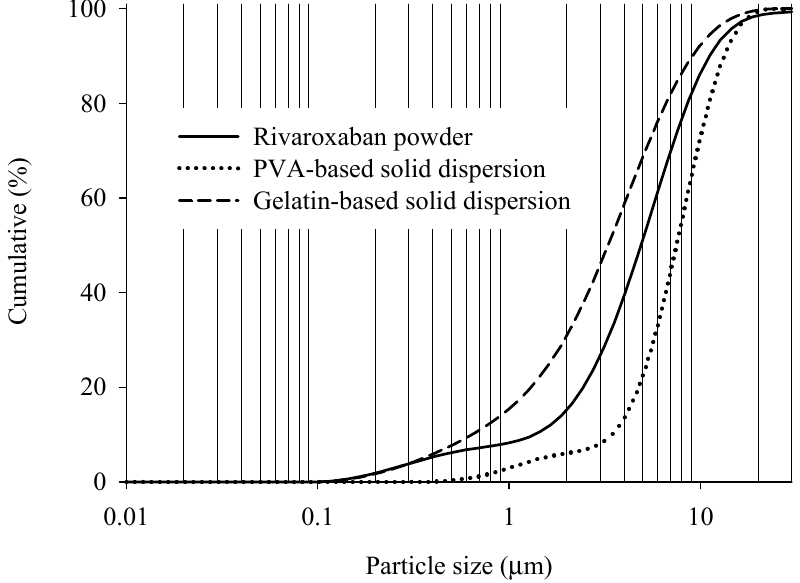
Figure 5. Particle size distribution of RXB and RXB-loaded solid dispersions.